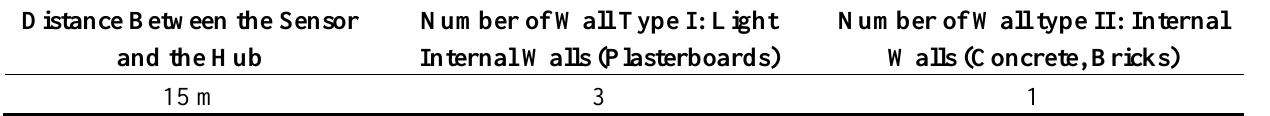
Experiment 6: Data collected from a house with a large gathering of people Distance Between the Sensor